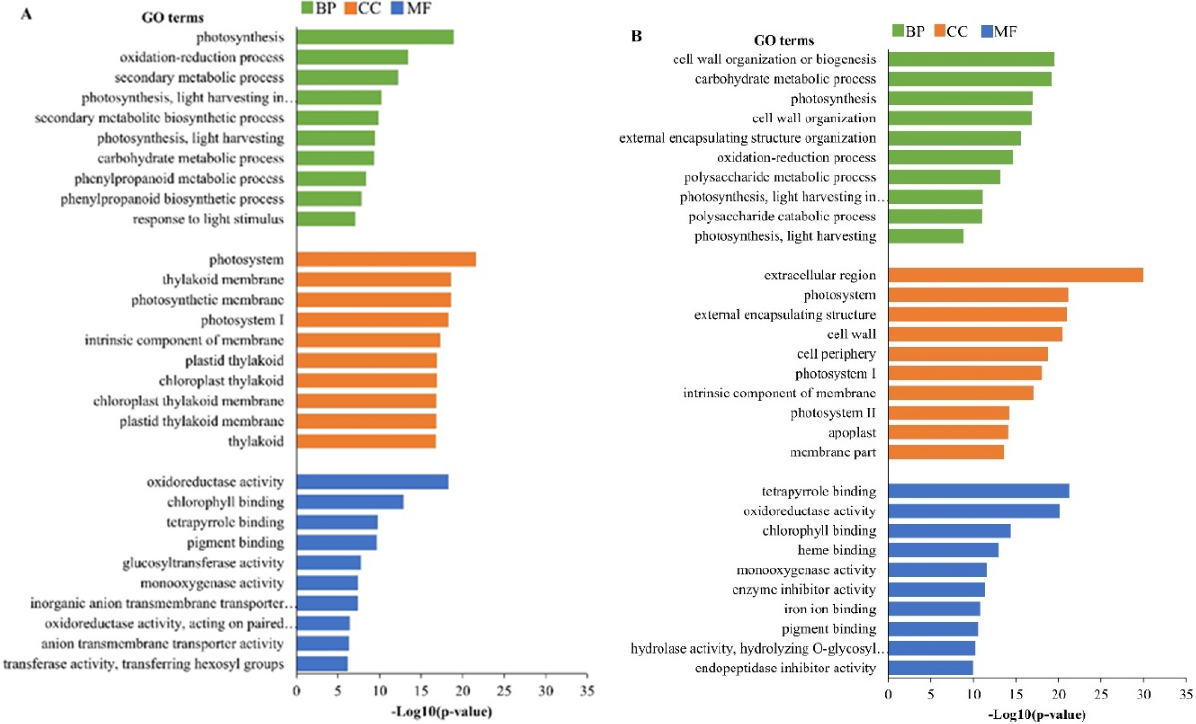
Figure 3. Top ten most enriched GO terms ( p value ≤ 0.05) of DEGs in the ( A ) A’ vs. B’ and ( B ) A’ vs. F’ comparison groups. The green, orange, and blue colors represent the GO terms belonging to biological processes (BP), cellular components (CC), and molecular functions (MF), respectively.